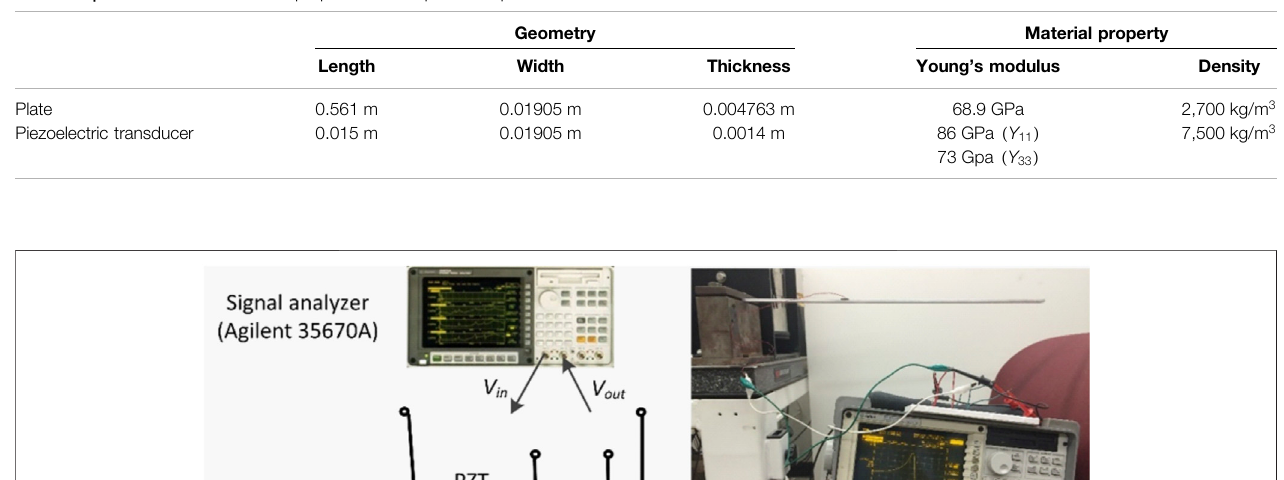
TABLE 1 | Geometrical and material properties of the plate and piezoelectric transducer.